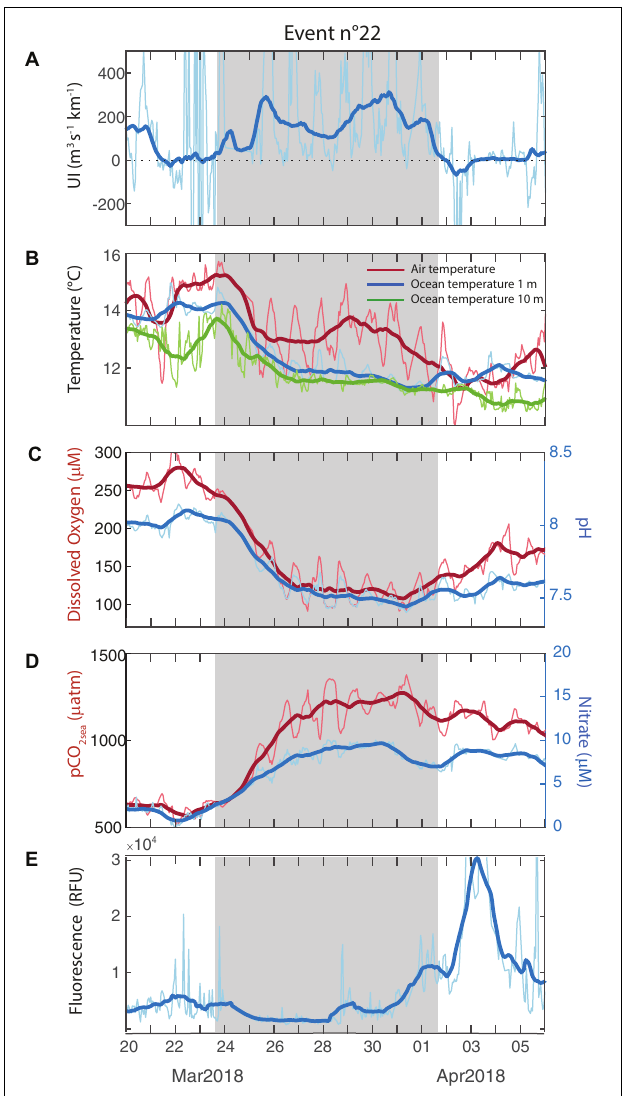
FIGURE 5 | Close-up to a strong upwelling event that began on March 25, 2018 (event number 22) followed by relaxed alongshore winds. (A) Upwelling Index, (B) Air temperature ( ◦ C, red line), ocean temperature at 1 m depth (blue line) and ocean temperature at 10 m depth (green line), (D) p CO 2 sea ( µ atm, red line) and Nitrate ( µ M, blue line), (C) Dissolved Oxygen ( µ M, red line) and pH (blue line) and (E) Fluorescence (RFU).